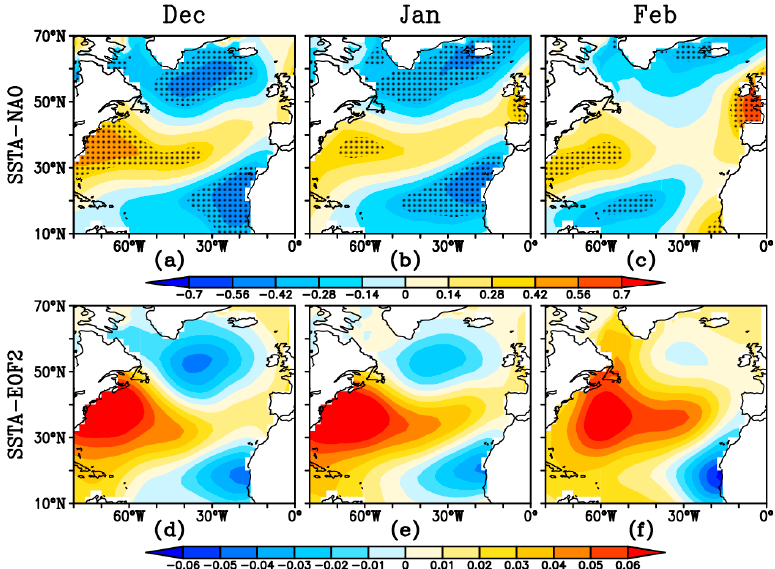
Figure 3. TCCs between the observed sea surface temperature anomaly (SSTA) and the NAO in December ( a ), January ( b ), and February ( c ). The second EOF mode of the SSTA in December ( d ), January ( e ), and February ( f ). Dotted areas indicate statistical significance at the 95% confidence level, as estimated by a local Student’s t -test.